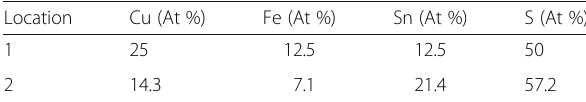
Table 2 EDX results of two different positions in the CFTS sample using the STEM microscope